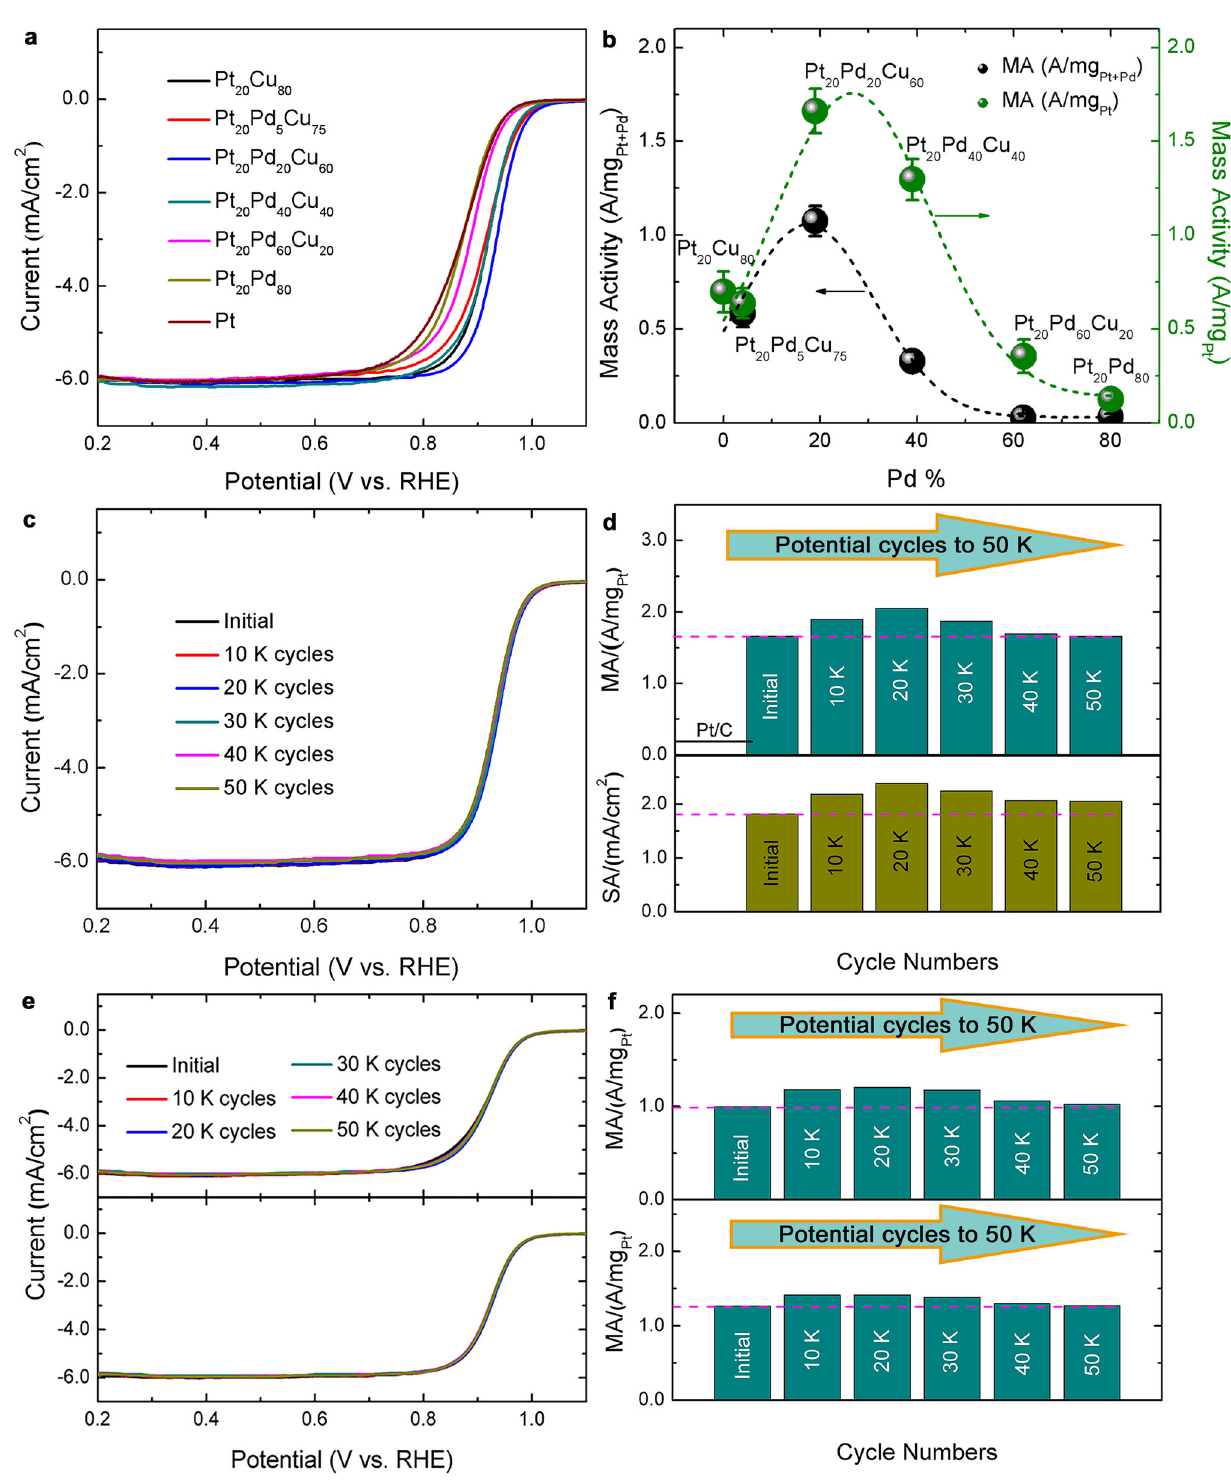
Fig. 2 Activity and durability of the ternary alloy electrocatalysts (PtPdM (M = Cu, Ni, Co)) for ORR. a RDE curves for Pt 20 Pd n Cu 80 – n /C and the commercial Pt/C catalysts with different compositions at 25 °C in O 2 -saturated 0.1 M HClO 4 at a scan rate of 10 mV/s and 1600 RPM (revolutions per minute). b The corresponding MA extracted from a at 0.900 V (vs. RHE) as a function of Pd% in NPs normalized by both PGM (Pt + Pd) and Pt (error bars represent s.d. based on three independent experiments). c RDE polarization curves of Pt 20 Pd 20 Cu 60 /C catalyst before cycling and after 10 K, 20 K, 30 K, 40 K, and 50 K cycles, respectively. d The corresponding MA and SA values extracted from c at 0.900 V (vs. RHE) of Pt 20 Pd 20 Cu 60 /C catalyst during potential cycling. e RDE polarization curves of Pt 20 Pd 40 Ni 40 /C (top) and Pt 20 Pd 40 Co 40 /C (bottom) catalyst before potential cycling and after 10 K, 20 K, 30 K, 40 K, and 50 K cycles, respectively. f The corresponding MA values extracted from e at 0.900 V (vs. RHE) of Pt 20 Pd 40 Ni 40 /C (top) and Pt 20 Pd 40 Co 40 /C (bottom) catalysts during accelerated durability test.